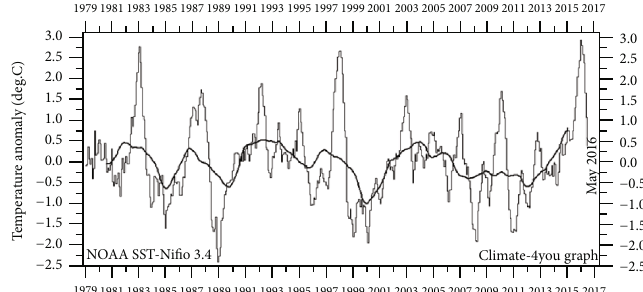
Figure 3: Changes of Earth ’ s average temperature between 1980 and 2017 years.